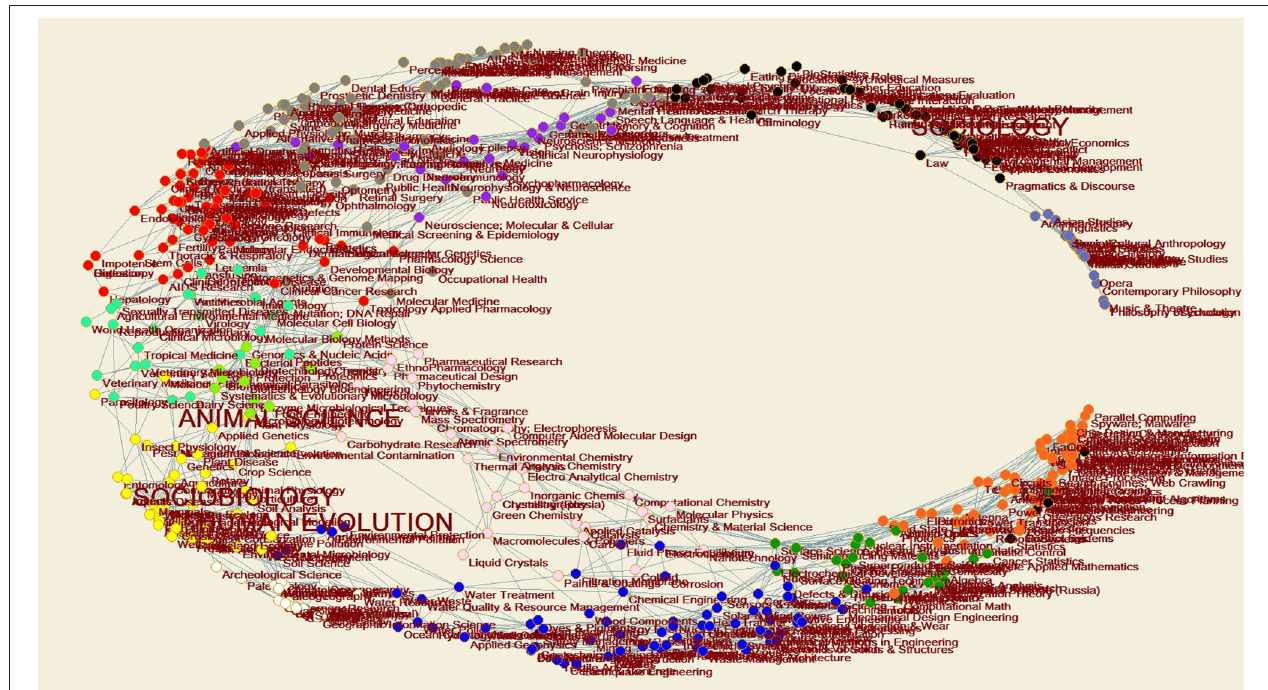
FIGURE 3 | A Map of Science created in Pajek (Batagelj and Mrvar, 2016) using the 2010 USCD map of science data and classification system covering 10 years (2001–2010) of Web of Science data and 8 years (2001–2008) of Scopus data (Börner et al., 2012). Sussman and Cloninger, 2011; Pierce and Bekoff, 2012; Barta,